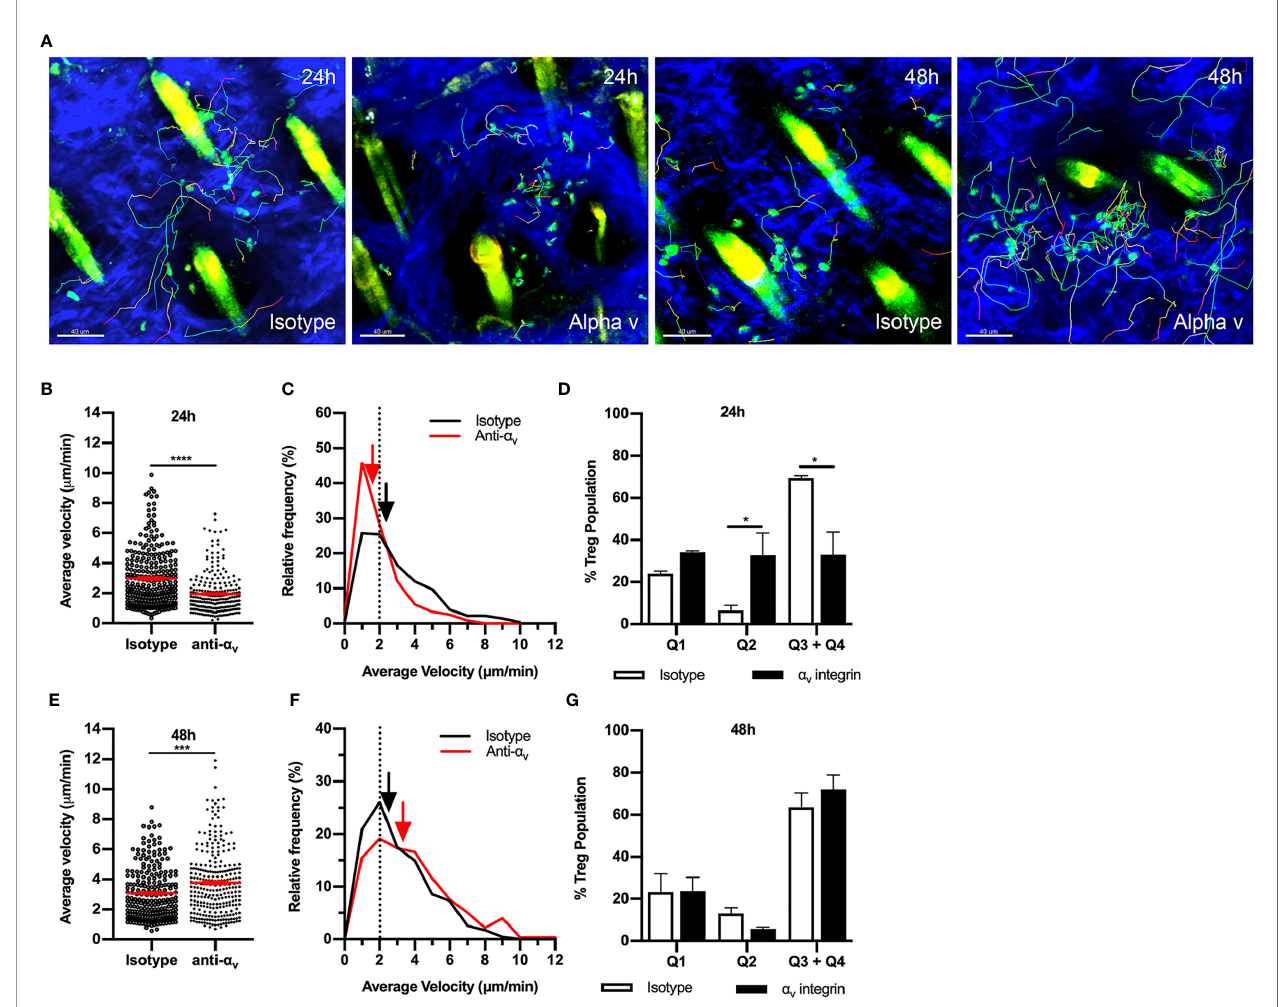
FIGURE 4 | a v integrin has a variable role in Treg migration during CS-induced in fl ammation. The contribution of the a v integrin to Treg migration in CS-in fl amed skin was assessed using MP-IVM of CS-in fl amed skin, following administration of anti- a v integrin or isotype control antibodies 2 h prior to visualization by MP-IVM. (A) MP-IVM images of Treg migration paths in Foxp3-GFP mice treated with anti- a v integrin or isotype control antibody at the 24 or 48 h CS timepoints. (B – G) Effect of anti- a v integrin treatment on Treg migration velocity 24 (B) or 48 h (E) after induction of CS. Data show velocities for individual Tregs as well as group mean ± sem. (C, F) Relative frequency distributions of the average velocities of individual Tregs from anti- a v integrin and isotype control antibody-treated mice, shown for 24 (C) and 48 h (F) post-CS induction. Arrows indicate the median velocity, and the dotted line indicates the 2 µm/min motility threshold. (D, G) Distributions of Tregs within the four quadrants of the velocity vs. con fi nement plots shown for 24 h (D) and 48 h (G) post induction of CS. Data represent the mean ± SEM of > 230 cells derived from 3-4 mice/group. Quadrant data represent mean ± SEM of data averaged from 3 fov/mouse. Data in (B, E) were analysed using Mann-Whitney test. *** p < 0.001, **** p < 0.0001. Quadrant data in (D, G) were compared using a multiple comparison t test using the Holm-Sidak method (alpha 0.05), * p < 0.05 for the comparisons